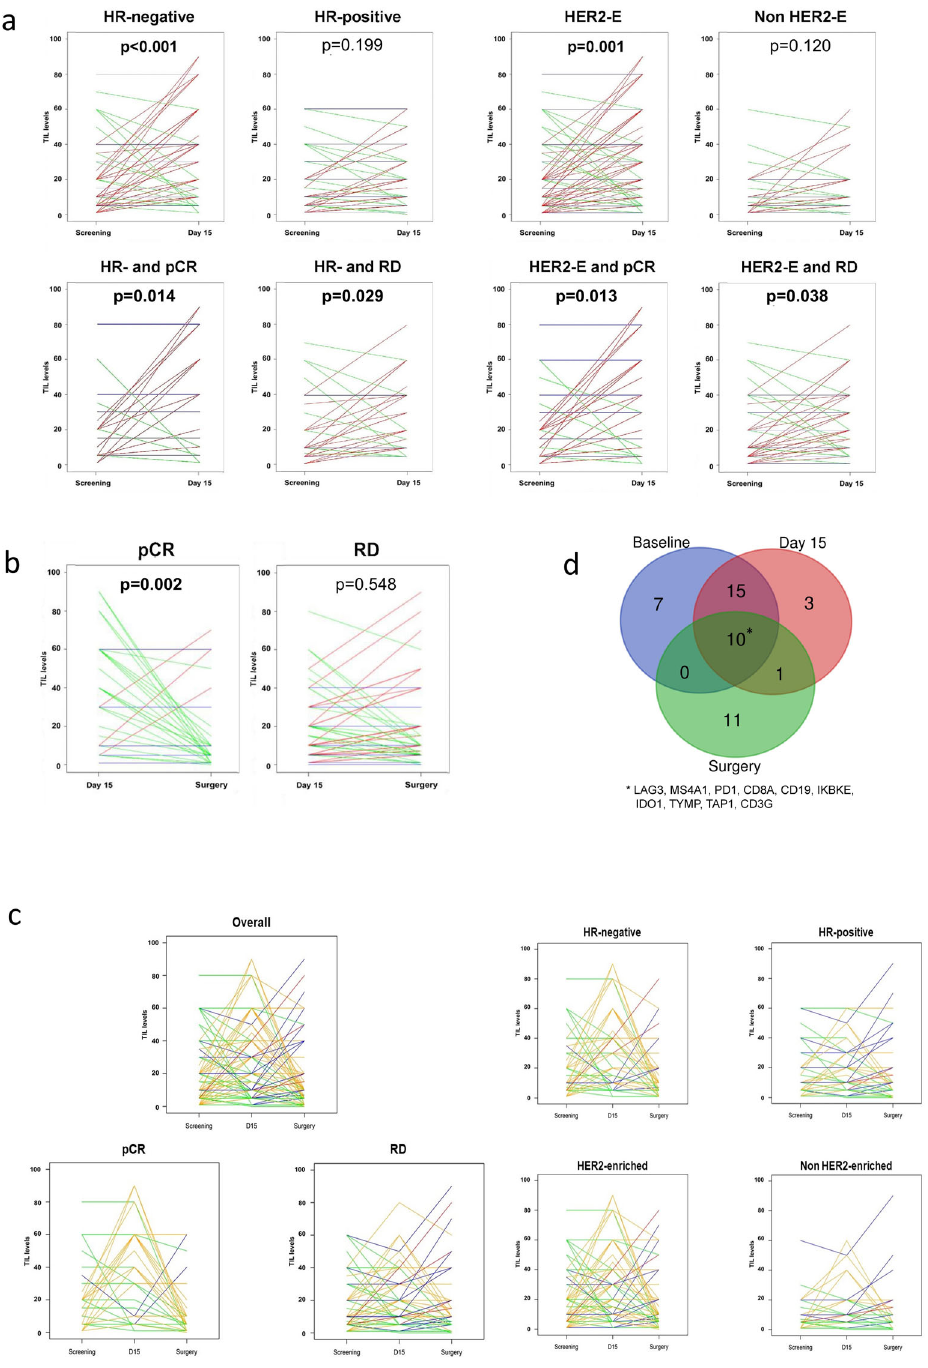
Fig. 4 Changes in sTILs across timepoints and correlation with gene expression. a Changes in TILs between baseline and day 15 according to hormone receptor [HR] status, subtype (HER2-enriched [HER2-E]) and response (pathological complete response [pCR] vs residual disease [RD]). Lines are coloured according to TIL dynamics: increase (red), stable (blue) or decrease (green). b Changes in TIL levels between day 15 and surgery according to response: pathological complete response [pCR] vs residual disease [RD]. Lines are coloured according to TIL dynamics: increase (red), stable (blue), or decrease (green). c Changes in TIL levels between baseline, day 15 and surgery in the overall study cohort and according to response (pathological complete response [pCR] vs residual disease [RD]), hormone receptor [HR] status and PAM50 subtype. Lines are coloured according to TIL dynamics: increase between baseline and day 15 followed by an increase between day 15 and surgery (red); increase between baseline and day 15 followed by stable or decrease between day 15 and surgery (orange); stable or decrease between baseline and day 15 followed by an increase between day 15 and surgery (blue); stable or decrease between baseline and day 15 followed by stable or decrease between day 15 and surgery (green). d Venn diagram representing overlaps in genes upregulated in relation to increase in TIL levels across the three